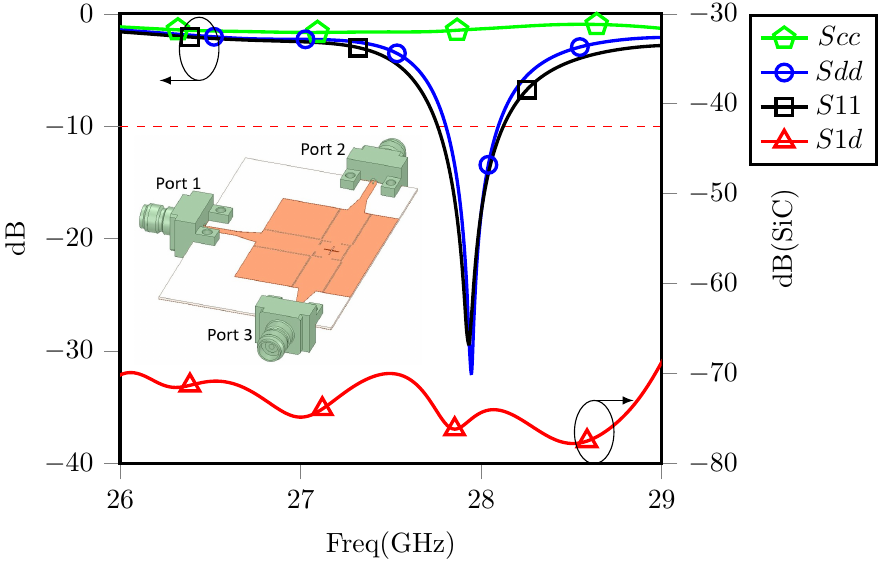
Figure 4. S-parameters of SIW differential